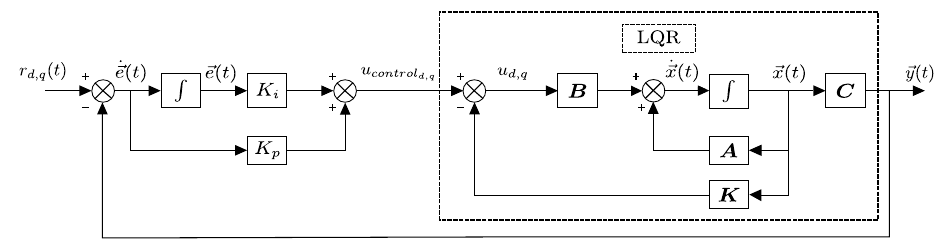
Figure 9. MG hybrid PI-LQR control block